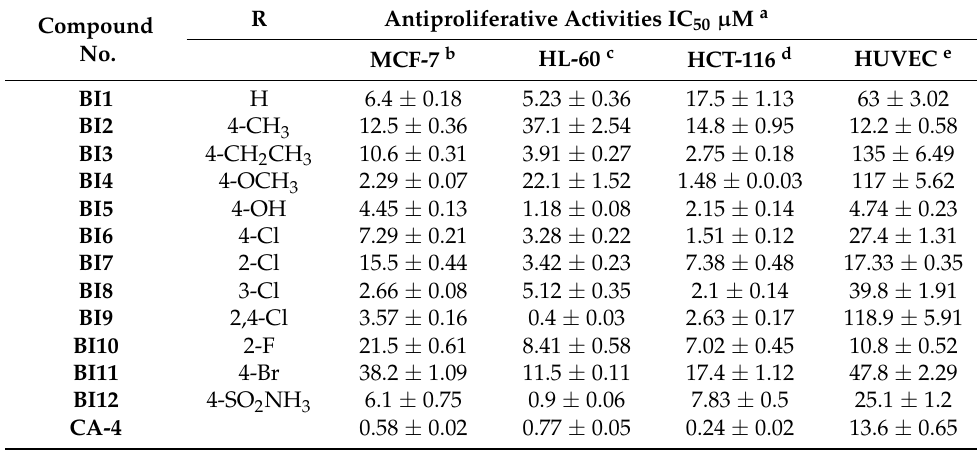
Table 1. Antiproliferative activity of benzotriazole analogues on selected cell lines (IC 50 [ µ M]).